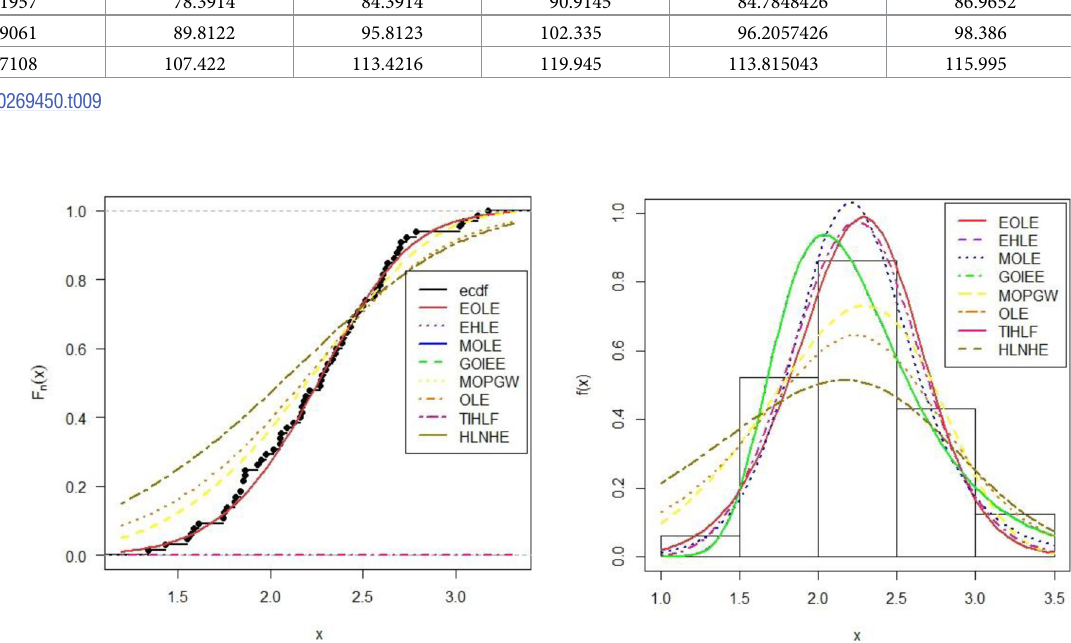
Fig 6. Estimated fitted CDF (left panel), Estimated fitted densities (right panel) of carbon fiber data